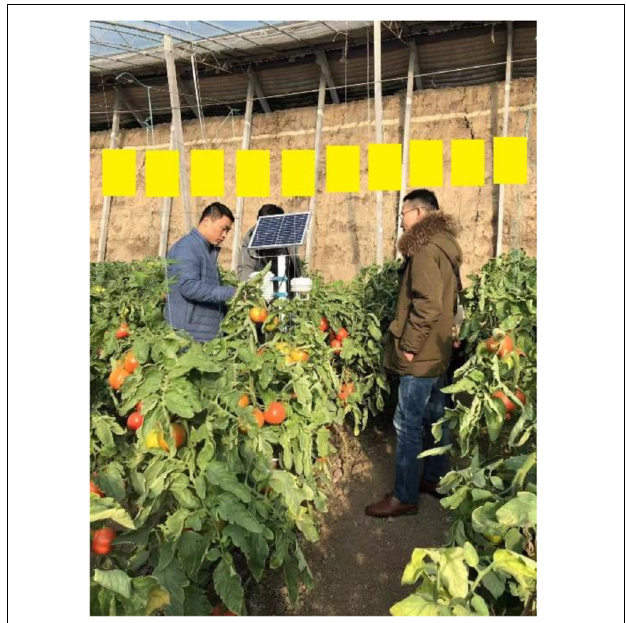
FIGURE 4 | The experimental image acquisition site.